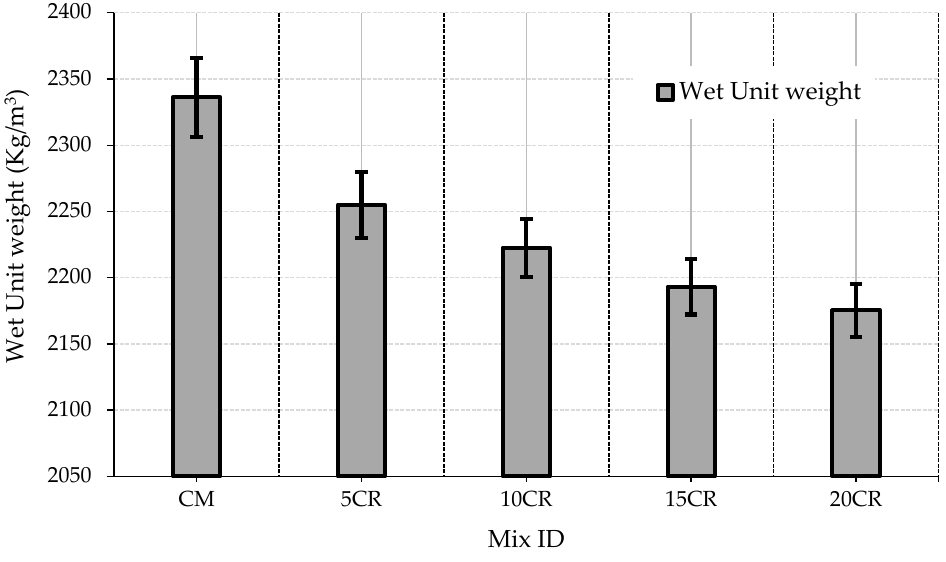
Figure 6. Wet unit weight results.